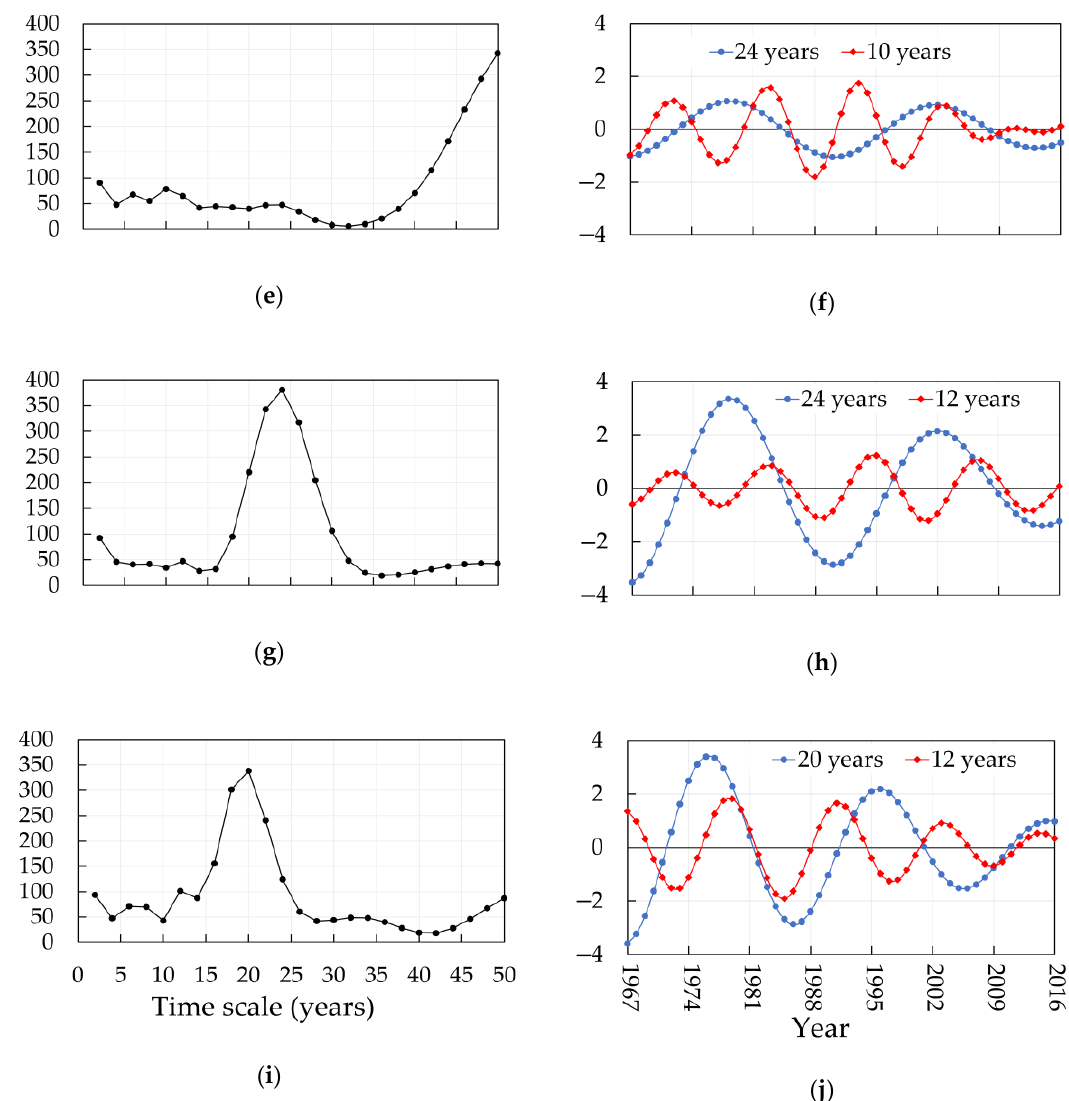
Figure 3. Wavelet variance plot of the annual average precipitation series and the seasonal average precipitation series on the QTP: ( a ) annual; ( c ) spring; ( e ) summer; ( g ) autumn; ( i ) winter. The real part of the wavelet coefficients of the annual average precipitation series and seasonal average precipitation series on the QTP: ( b ) annual; ( d ) spring; ( f ) summer; ( h ) autumn; ( j )